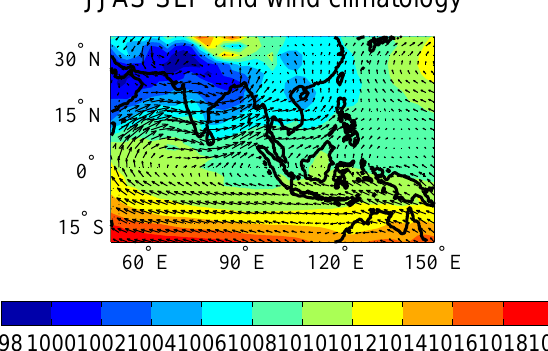
Fig. 1. JJAS climatology of the ERA-40 SLP and 850hPa wind field over the Asian monsoon region. SLP units: 2hPa, and the max- imum wind speed is 18ms − 1 .